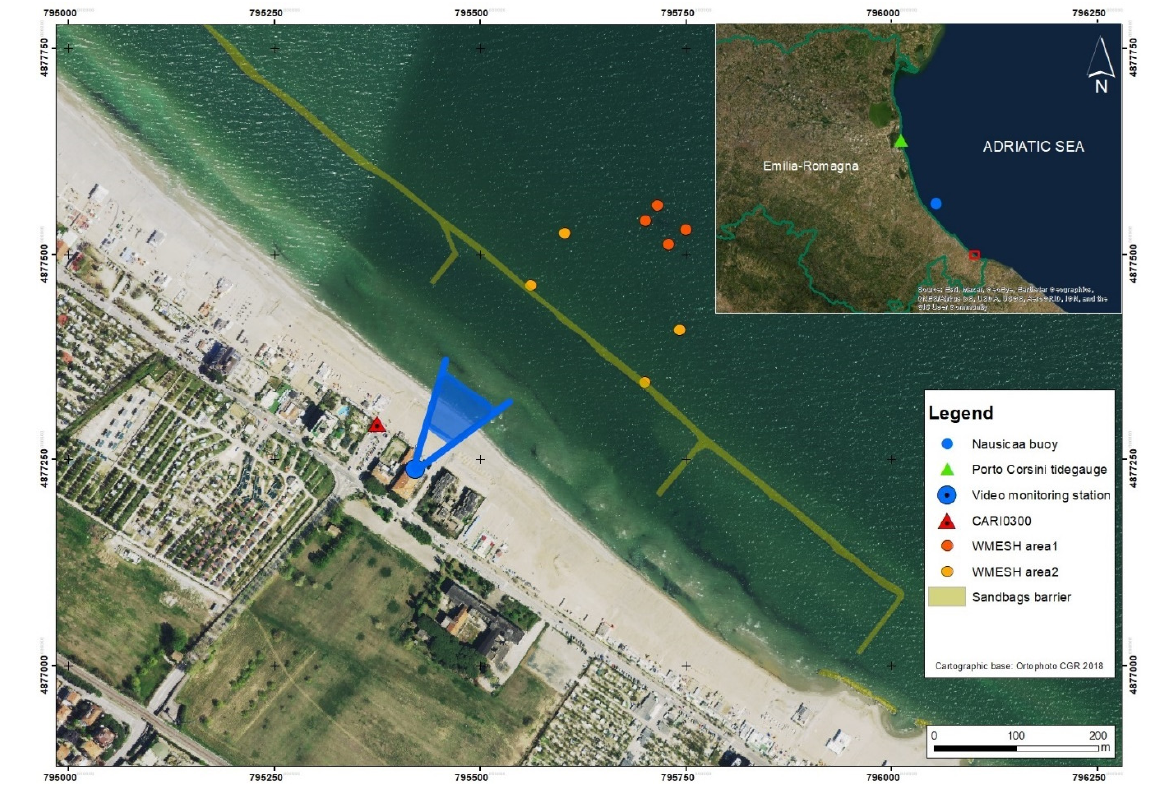
Figure 1. Location of the study area (red rectangle in the inset) in the Emilia-Romagna coastal belt. The location of the Nausicaa buoy and the Porto Corsini tide gauge is also indicated in the inset map. The position of the video monitoring station and its view area and that of the used topographic benchmark (CARI0300) are indicated on the beach, while the locations of a sandbags barrier and WMESH modules are mapped in the submerged beach.